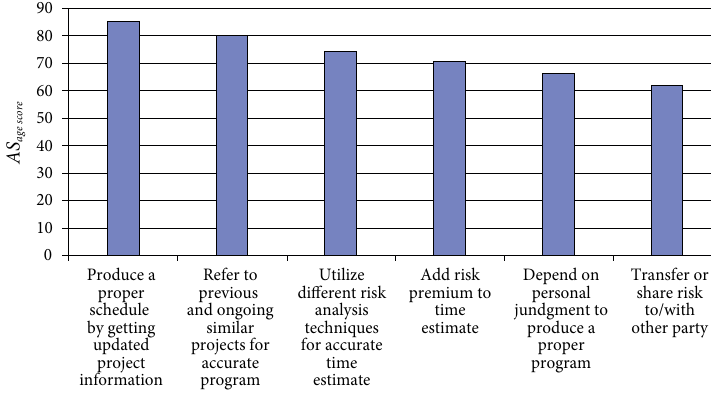
Fig. 2. Effectiveness of preventive risk management